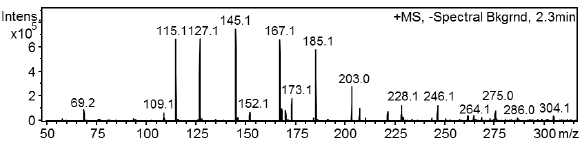
Figure 2. Typical MS of 1.5 M Gly in 3 M AS at 2.3 min retention time. 2 Fig. 2. Typical MS of 1.5 M Gly in 3 M AS at 2.3min retention time.